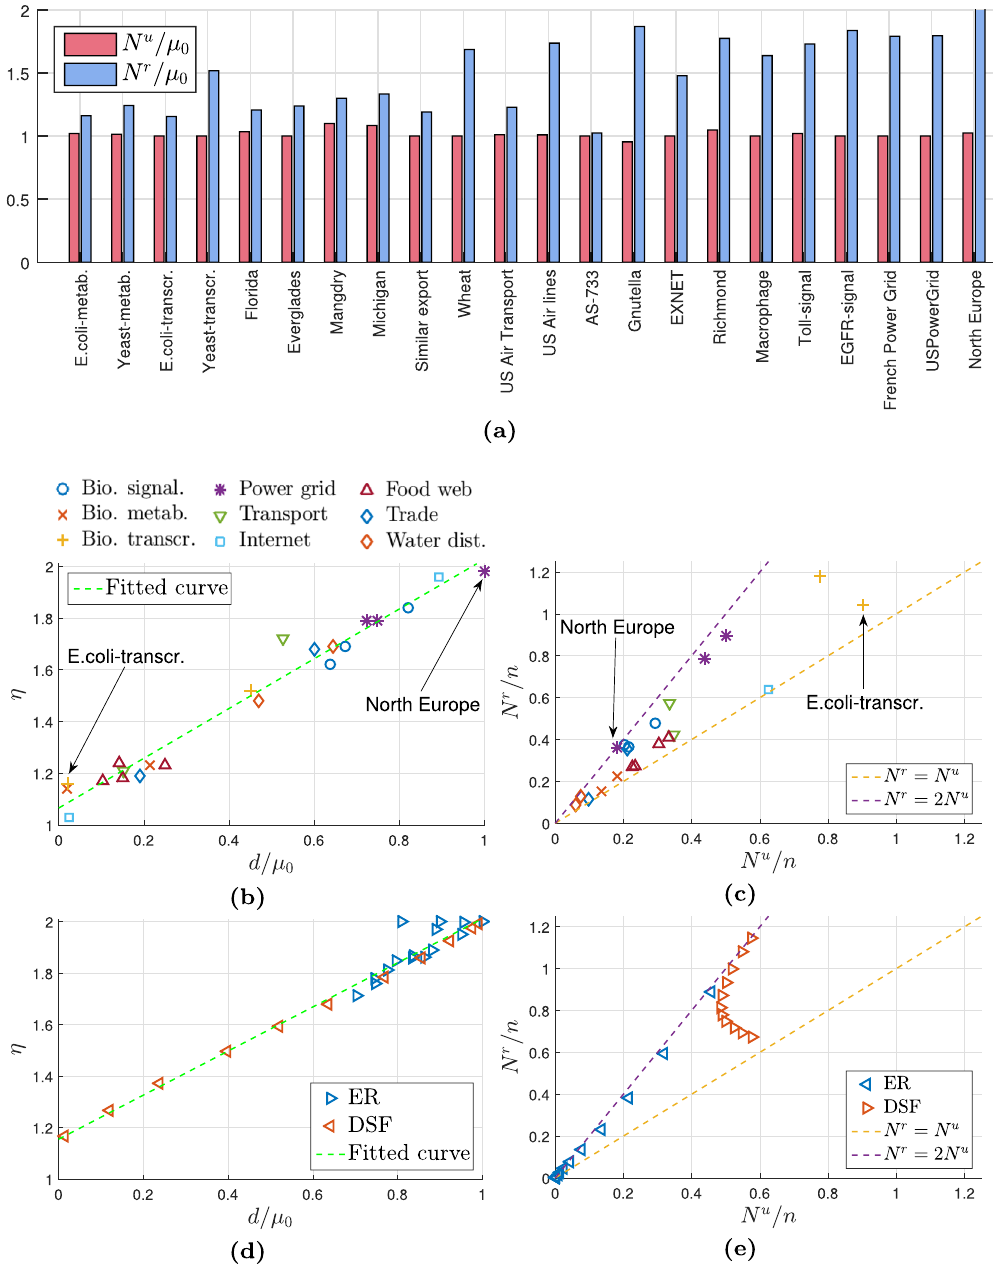
Figure 6. ( a ) The lower bound N u ≥ μ 0 , or N u / μ 0 ≥ 1 is in most cases achieved for the real-world networks in Table 3. ( b ) Here η is plotted against the ratio d / μ 0 ∈ [0, 1] for the networks of Table 3. This ratio reflects in what extent  A ( )  is generated by roots and dilations. A linear regression curve is fitted to the data-points. The results for the different networks within a specific category are in most cases similar. ( c ) In this plot N r and N u are normalized with the network size. The admissible region N u ≤ N r ≤ 2 N u is the area between the dashed lines. Here we can see that some networks require a large number of unrestricted or unilateral control inputs (far from the origin) although the ratio η is close to one (near the orange line). ( d ) The same plot as in ( b ) but for the Erdős–Rényi and directed scale free networks of Figs 4 and 5. There is one marker for each configuration. The outliers in the top right corner are dense Erdős–Rényi networks for which the null space parameters are of little importance in computing η . ( e ) Same as ( c ) but for the Erdős–Rényi and directed scale free